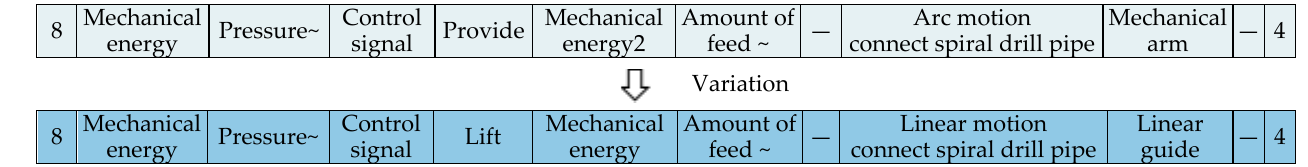
Figure 28. Substance-field model with insufficient action of spiral drill pipe for digging tree pits.